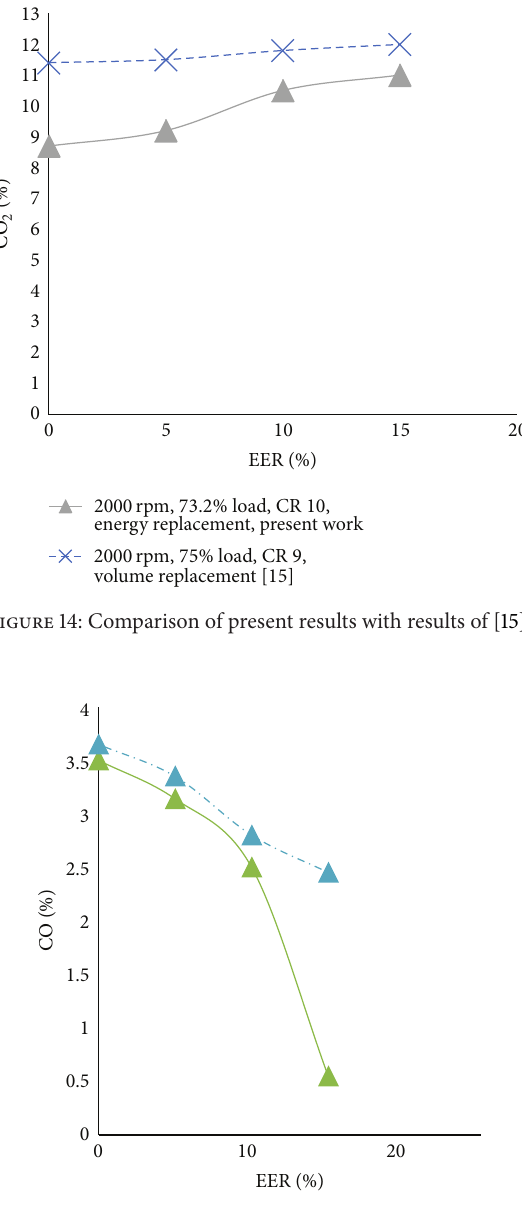
(4) With increasing the compression ratio the concentra- tion values of the CO 2 and NO concentration values of the CO and UHC